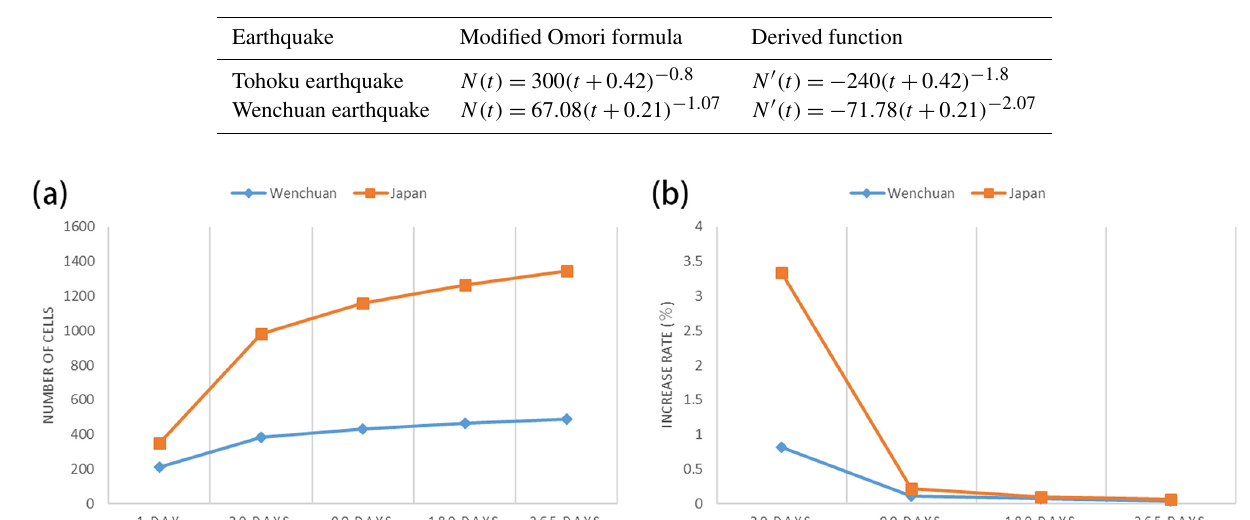
Table 2. Modified Omori formula and derived function of typical earthquake cases